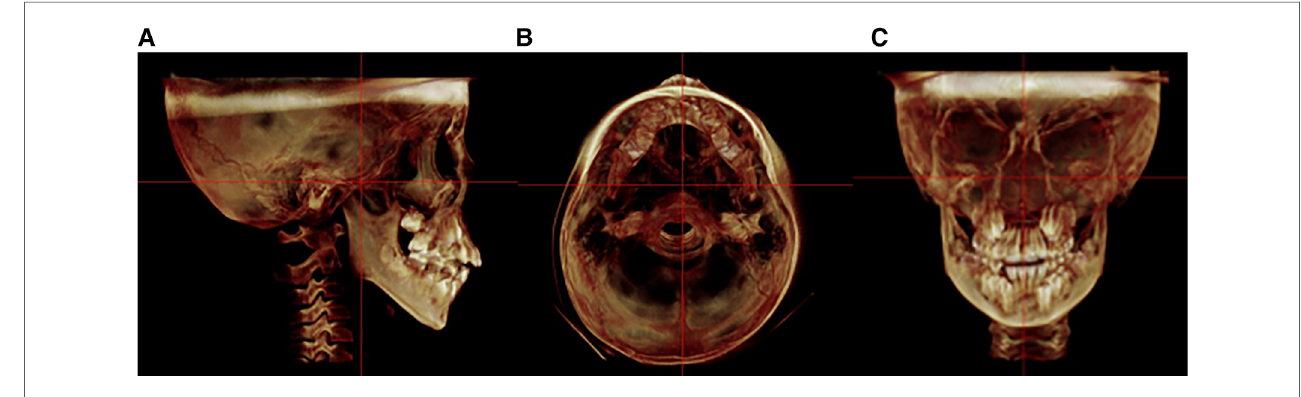
FIGURE 2 Standardized orientation of CBCT for measurement. (A) Sagittal plane. (B) Horizontal plane. (C) Coronal plane.